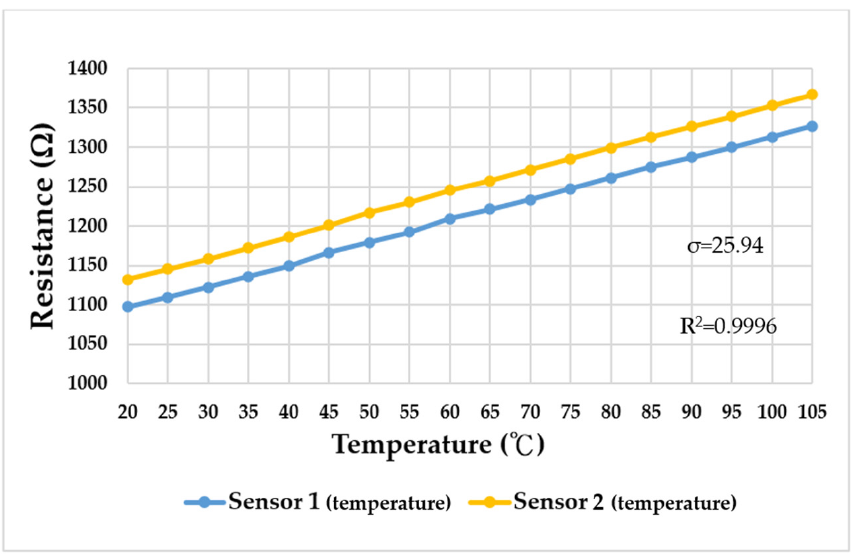
Figure 4. Calibration curve of the micro temperature sensor (original resistance value).